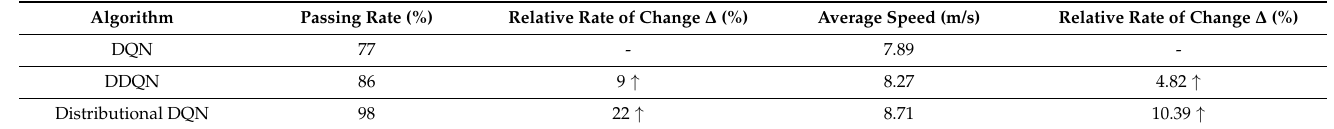
Table 3. Test results of using different algorithms in the intersection